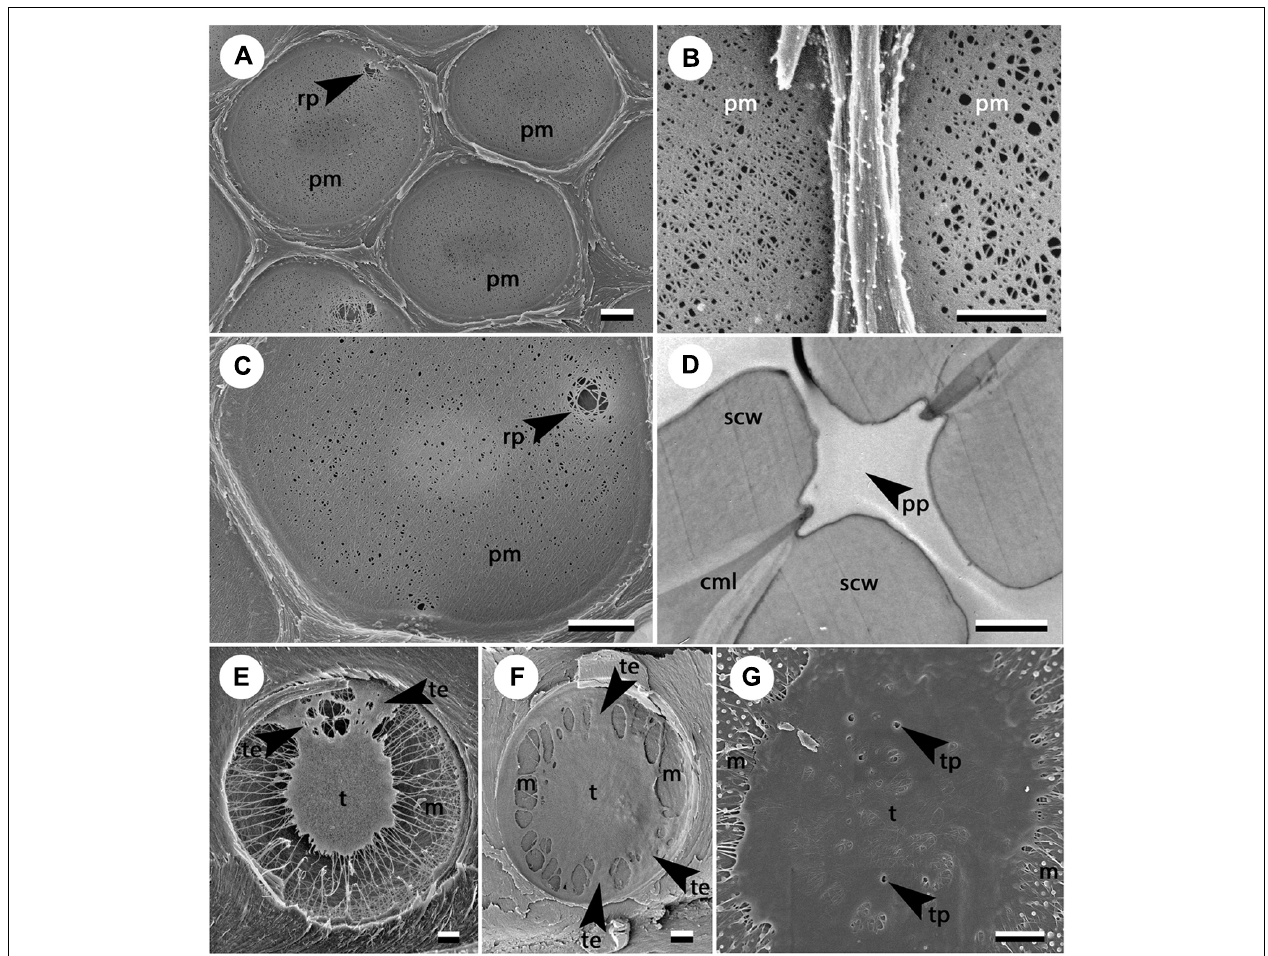
FIGURE 1 | Structural variability in adjacent pits (A, B) and examples of profound irregularities in pit structure (C–E). (A) Pit field in Acer negundo in which some pit membranes are homogenously porous while others show rare large pores (photo courtesy of Brendan Choat); (B) adjacent pits in hybrid poplar Populus trichocarpa × deltoides showing different average porosity; (C) rare large pore independent of the average porosity in Acer negundo (photo courtesy of B. Choat); (D) perforated pit in a non-conductive ITE in